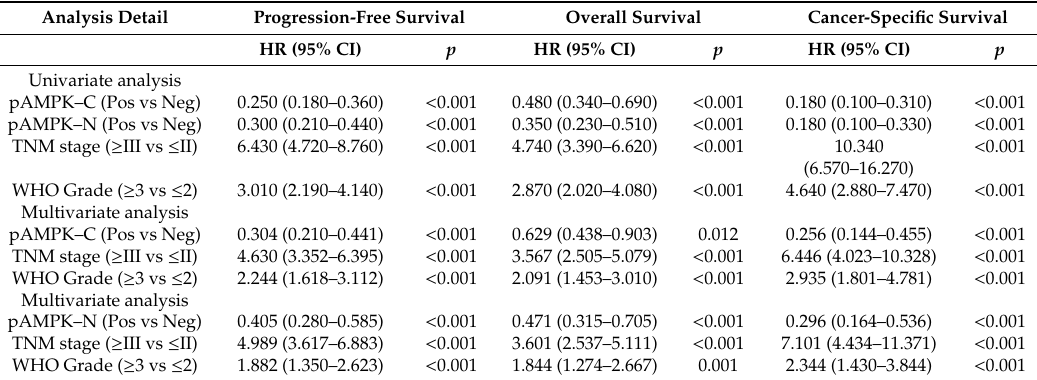
Table 3. Cox regression analyses for pAMPK expression of the validation